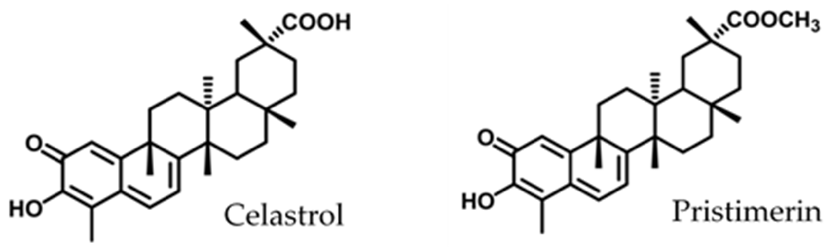
Figure 1. Structure of triterpenoid methylene quinones.